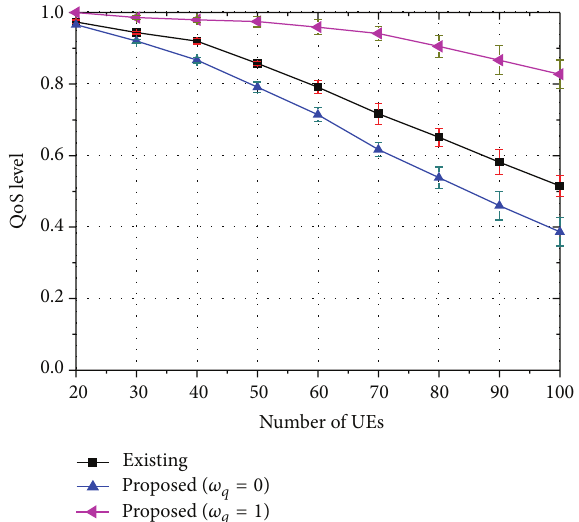
Figure 11: QoS level of 16-viewpoint 3D A/V traffic ( 𝛽 = 0.9 ).